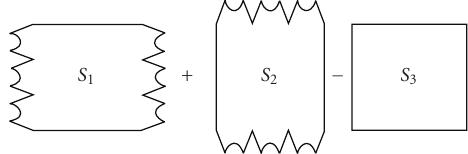
Figure 4: Decomposition of aperture S into three parts S 1 , S 2 , and S 3